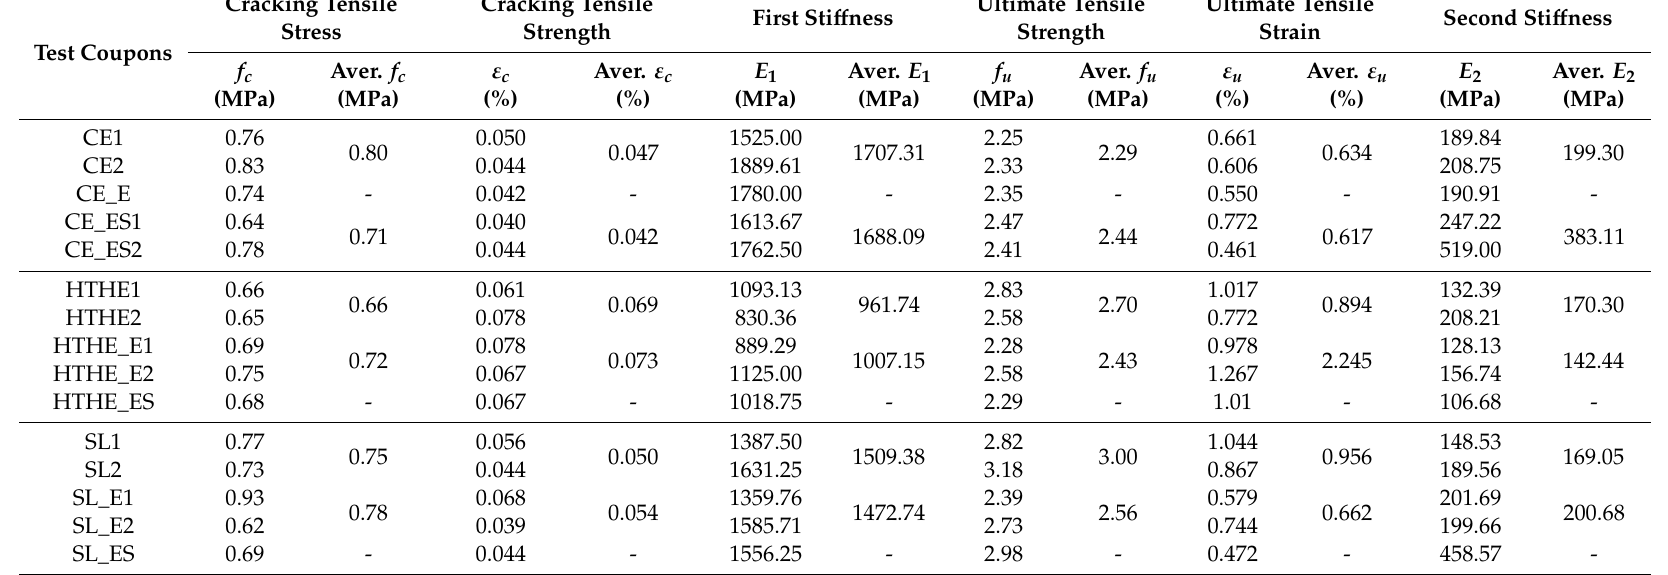
Table 2. Tensile behavioral characteristics obtained from the experimental